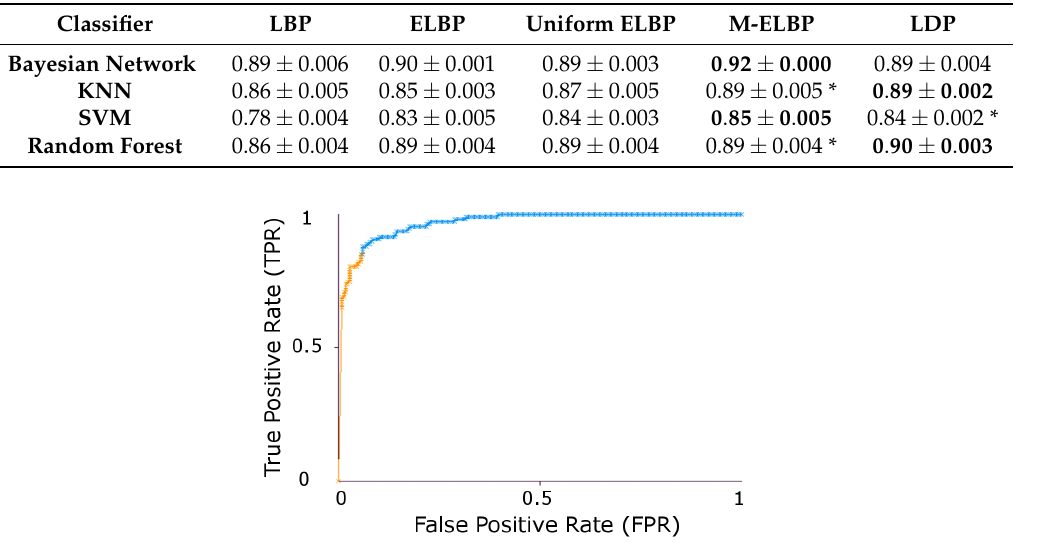
Table 8. Area under ROC ( A z ) classification results for LBP variants using ROI size 256 × 256 pixels for a 10 run 10 fold cross validation. * indicates that the CA% are not significantly different from the best result using an unpaired t test ( p = 0.05) level).